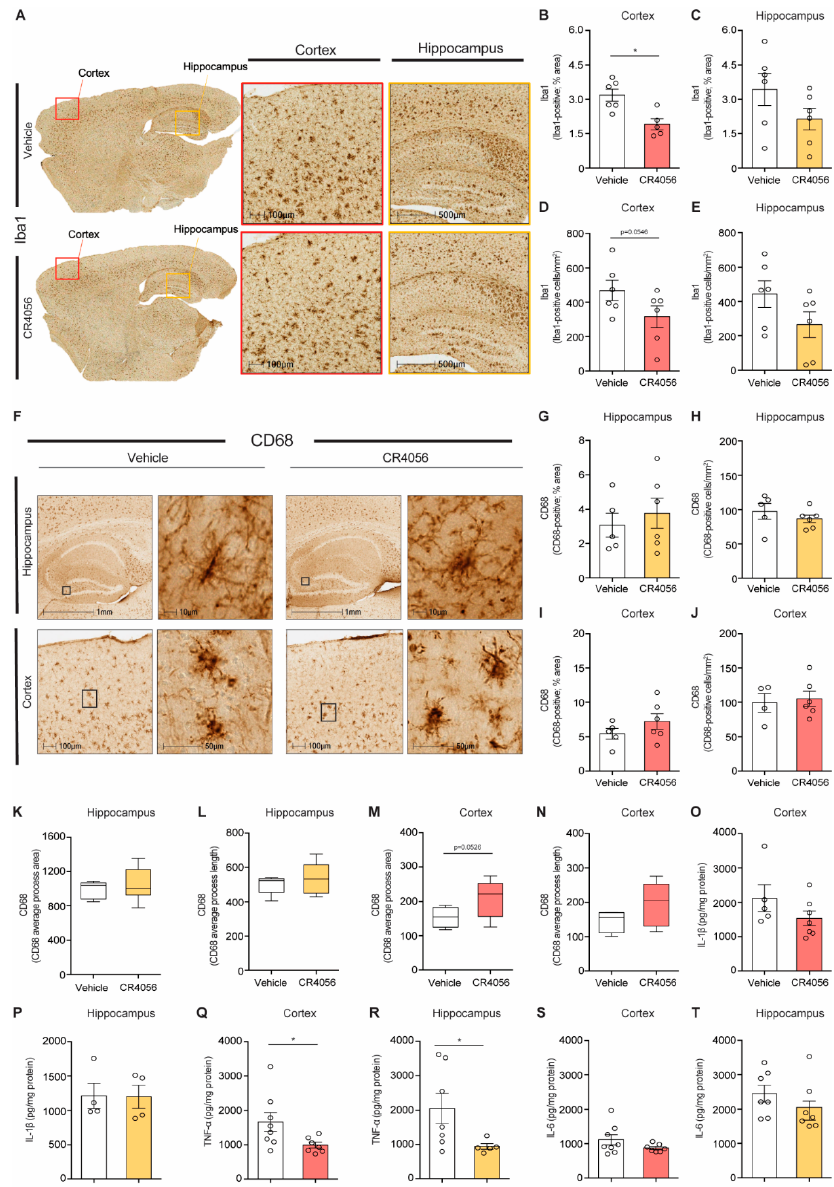
Figure 5. Sub-chronic CR4056 treatment has anti-inflammatory effect in 5xFAD mouse brain. ( A ) Representative images of Iba1 immunostaining in sections from 5xFAD mice after treatment with vehicle or CR4056. ( B , C ) Quantification of percentage of area covered with Iba1-positive staining in cortex ( n = 5–6 per group) and hippocampus ( n = 6 per group) of 5xFAD mice. ( D , E ) Quantification of Iba1-positive cells in cortex and hippocampus of 5xFAD mice, respectively ( n = 6 per group). ( F ) Representative images of CD68-immunohistochemistry in cortex and hippocampus in sections from 5xFAD mice after with vehicle or CR4056. ( G , H ) Quantification of percentage of area covered and number of CD68-positive cells, respectively, in the hippocampus of 5xFAD mice ( n = 5–6 per group). ( I , J ) Quantification of percentage of area covered and number of CD68-positive cells, respec- tively in the cortex of 5xFAD mice ( n =5–6 per group). ( K , L ) Measurement of process thickness and length of CD68-positive cells in hippocampus ( n = 5–6 per group) and cortex (( M , N ) n = 4–6 per group) of 5xFDA mice. ( O – T ) Quantification of expression of cytokines by ELISA in homogenate from cortex and hippocampus of 5xFAD mice after CR4046 treatment. IL-1 β (( O , P ), n = 4–7 per group), TNF- α (( Q , R ), n = 5–8 per group) and IL-6 (( S , T ), n = 7–8 per group). Columns represent mean ± SEM. One-tailed Student’s t -test, * p <